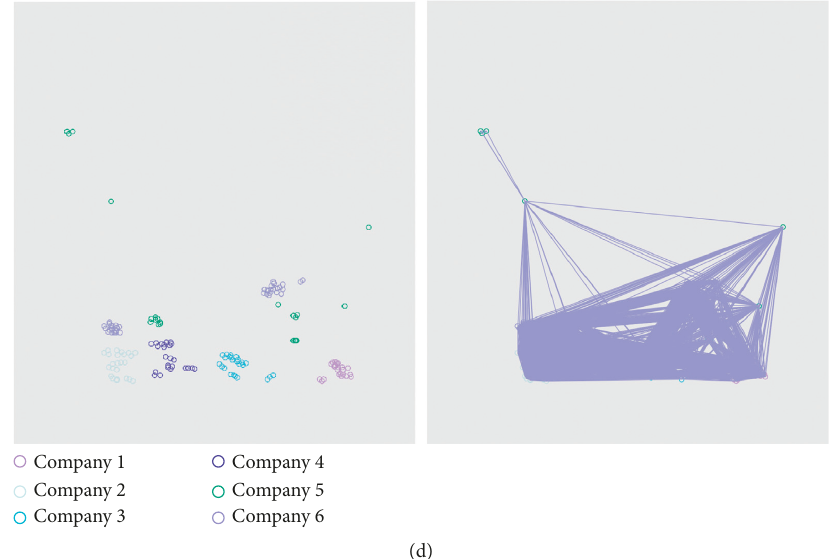
Figure 8: The locations of the nodes and the connections between them in the different phases of the Anglova scenario. (a) Phase 1: the battalion moves in a single column away from the HQ ( t � 1860s). (b) Phase 2: the battalion splits up over the two main roads on the area ( t � 2900s). (c) Phase 3: the battalion splits up onto many roads grouped in companies. (d) Phase 4: the battalion further splits up to the level of platoons ( t � 7780s).